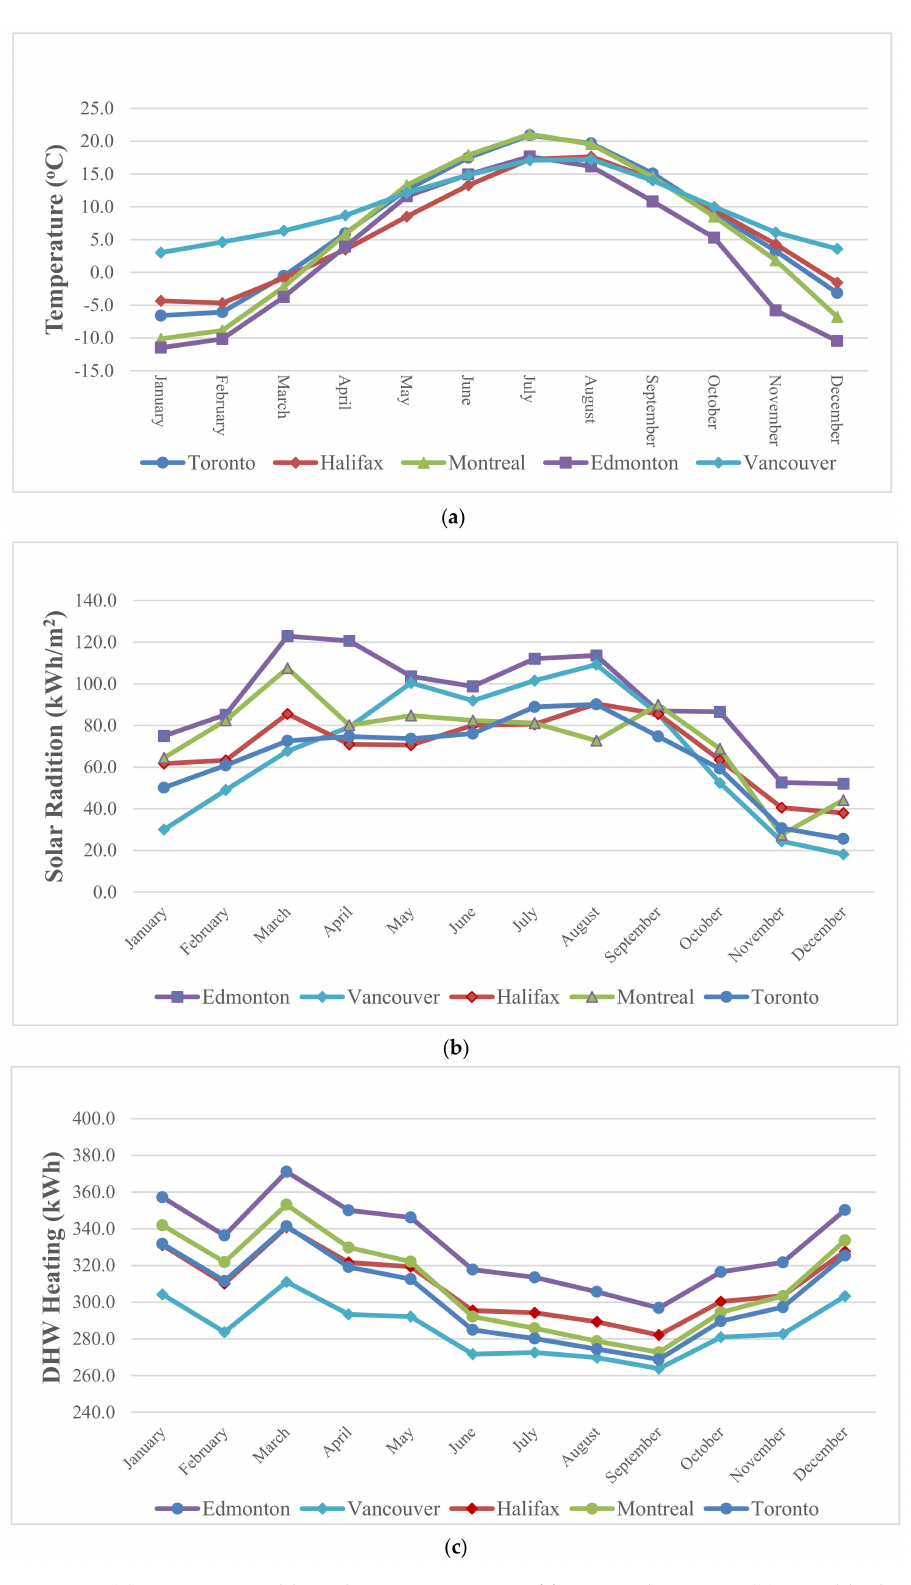
Figure 16. ( a ) Average monthly ambient temperature of five Canadian cities; ( b ) Monthly direct beam radiation on surface; ( c ) Monthly DHW base case